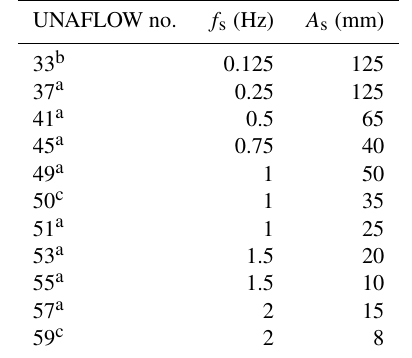
Table 4. Numerical-experimental test matrix: a exp + AL, b exp + BEM + AWSM, c exp + all codes. The values of the harmonic-surge frequencies ( f s ) and amplitudes ( A s ) are